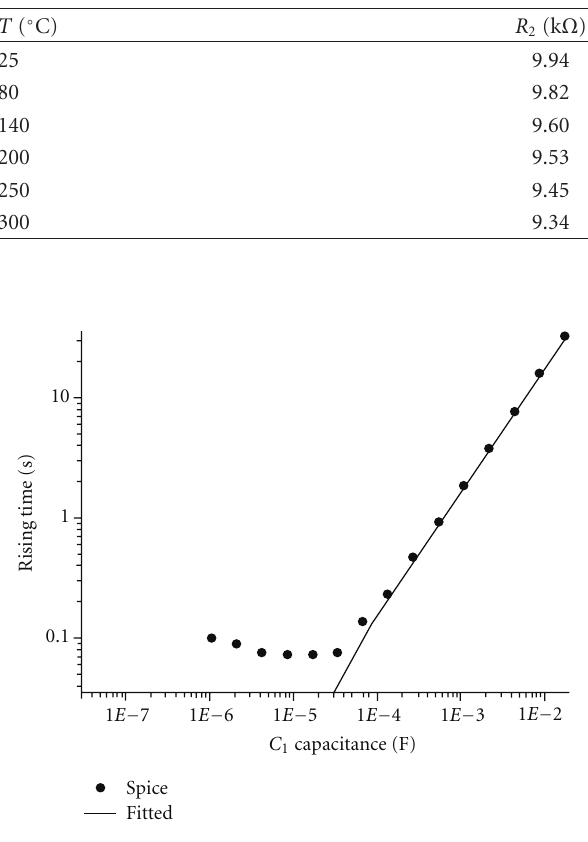
Figure 26: A linear response characteristic between the rising time and C 1